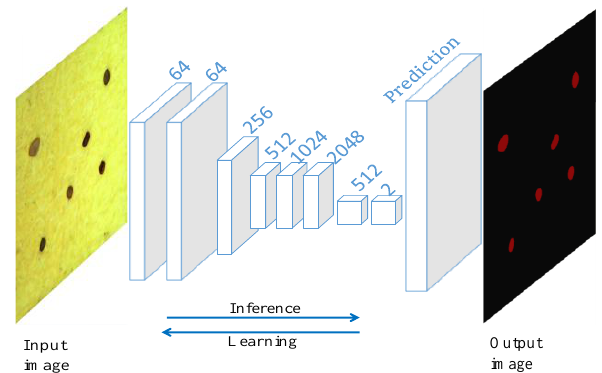
Figure 1. A diagram of sand-grain images semantic-segmentation network model.